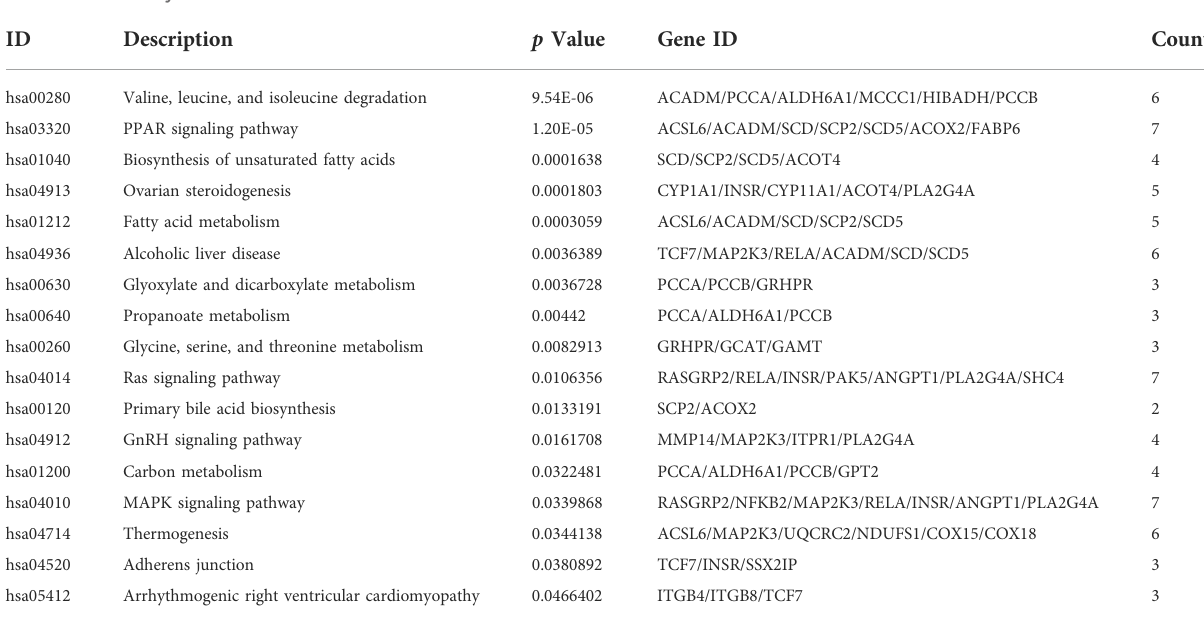
TABLE 1 KEGG analysis of